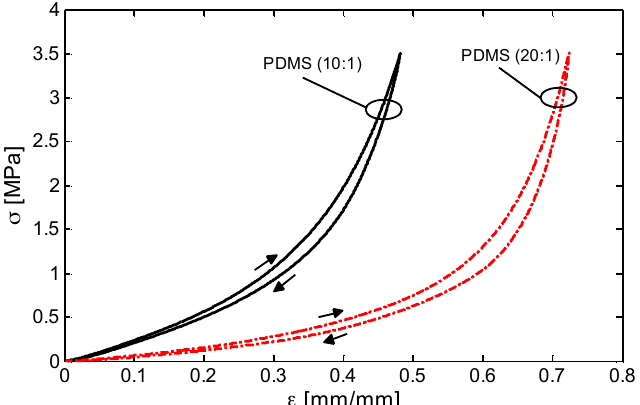
Figure 8. Stress-strain response of two bulk PDMS samples produced with a stoichiometric ratio 10:1 and 20:1 of PDMS prepolymer and curing agent for a loading-unloading compression test.